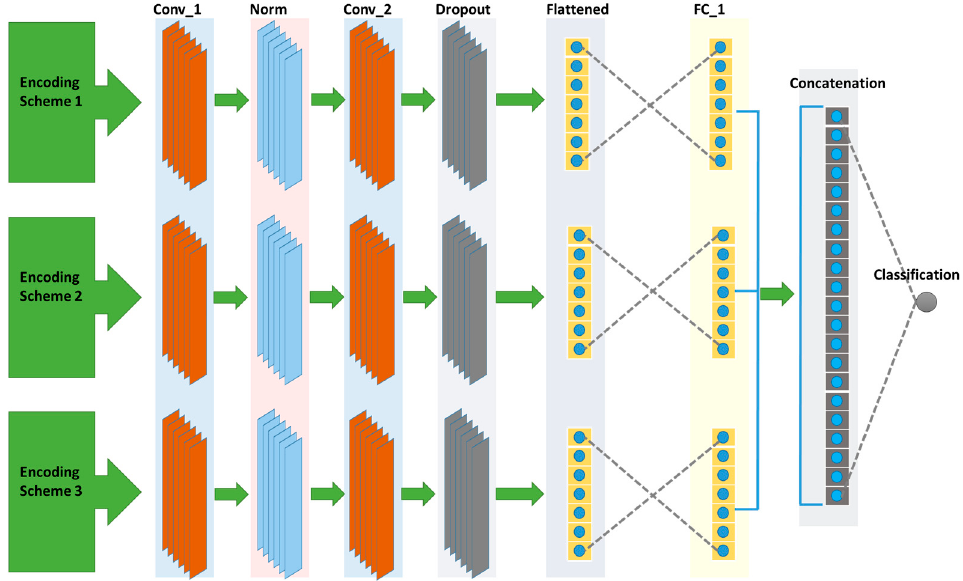
Figure 2. Branch convolutional neural network for identifying modification sites in different RNA sequences. The top branch uses the RNA sequence represented by the circular encoding scheme as input. The second and third branches use RNA sequence represented by one-hot encoding and NCP encoding schemes, respectively, as inputs. Each network branch comprises two convolution layers, one normalization layer, and two fully connected layers. The last fully connected layer uses concatenated features from three branches and predicts modification sites using a single output